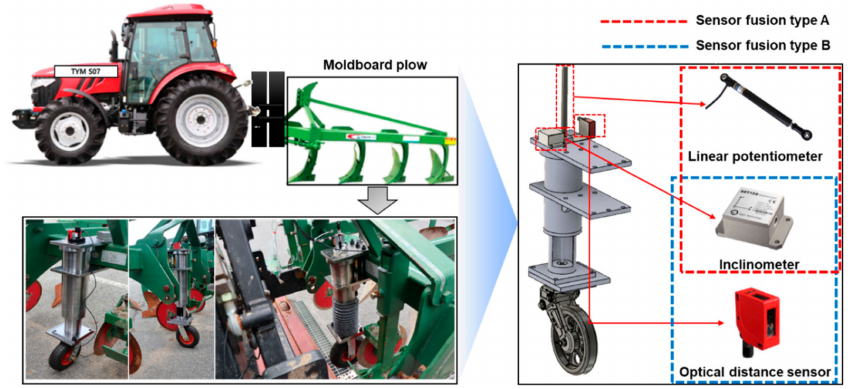
Figure 3. Configuration of the real-time tillage depth measurement